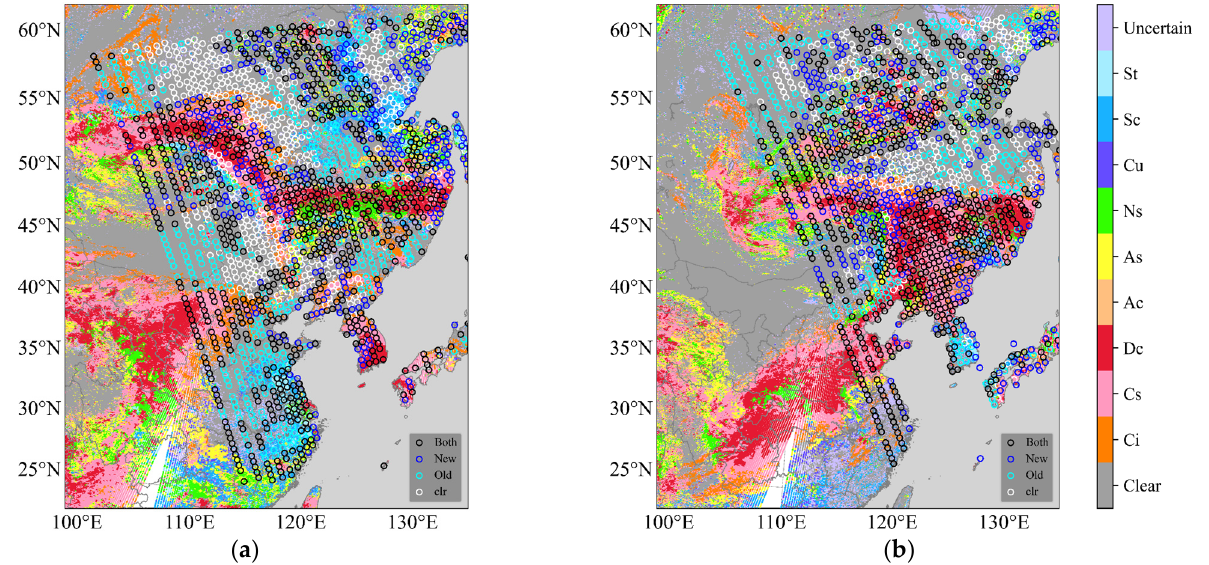
Figure 8. As in Figure 7 but with the black circles representing cloudy FOVs detected by both cloud detection methods, the blue circles denoting cloudy FOVs detected by only the new method, and the cyan circles showing the cloudy FOVs detected by only the old method, at ( a ) 0600 UTC 26 June and ( b ) 0600 UTC 28 June 2019.